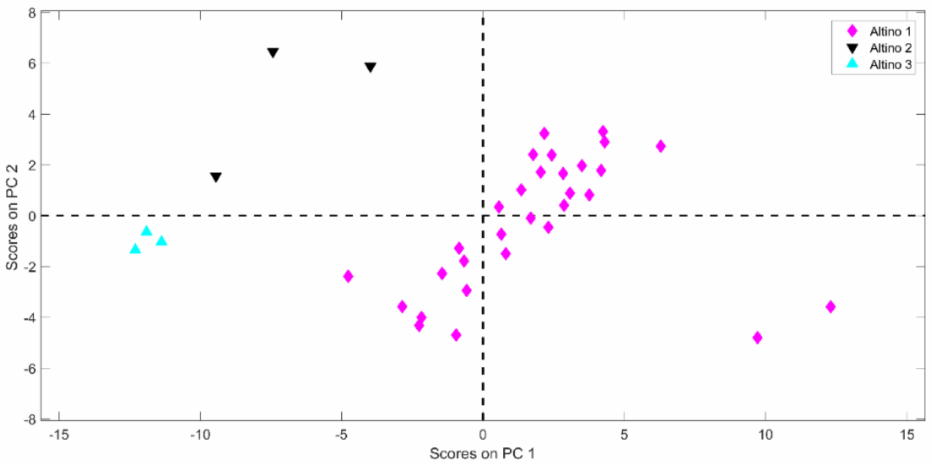
Figure 3. PC-plot. Projection of the Altino samples onto the space spanned by the first two